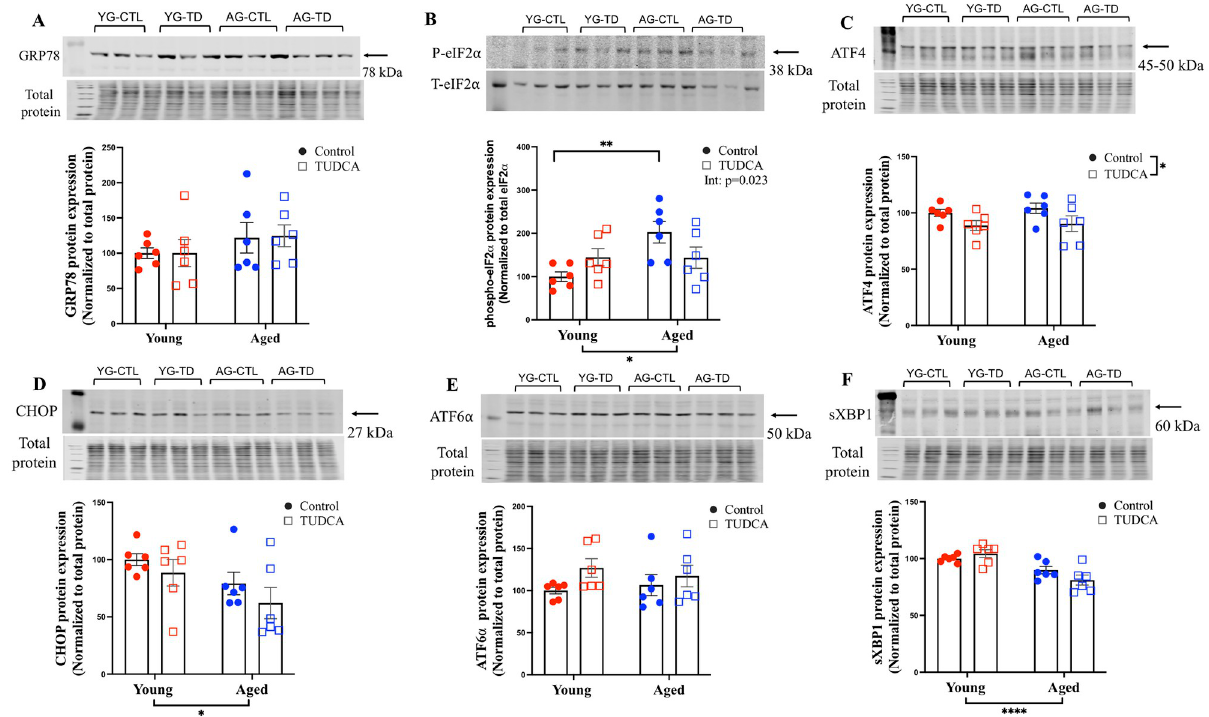
Fig 3. Female labyrinth zone. Western blot analysis of female labyrinth zone (A) GRP78, (B) phospho-eIF2 α , (C) ATF-4, (D) CHOP, (E) ATF-6 α , and (F) sXBP-1 normalized to total protein (except phospho-eIF2 α normalized to Total eIF2 α ) in female placenta labyrinth zone of young (3–4 months; in red) and aged control dams (9–9.5 months; in blue) with (open squares) or without (closed circles) TUDCA-treatment on gestational day 20. Data are presented as mean ± SEM and expressed as percentage of control (i.e., the mean of the young control dams); analyzed by two-way ANOVA with Sidak’s multiple comparisons post-hoc test; * p < 0.05, ** p < 0.01, **** p < 0.0001; n = 6/group. YG-CTL = Young control dams; YG-TD = Young TUDCA- treated dams; AG-CTL = Aged control dams; AG-TD = Aged TUDCA-treated dams.